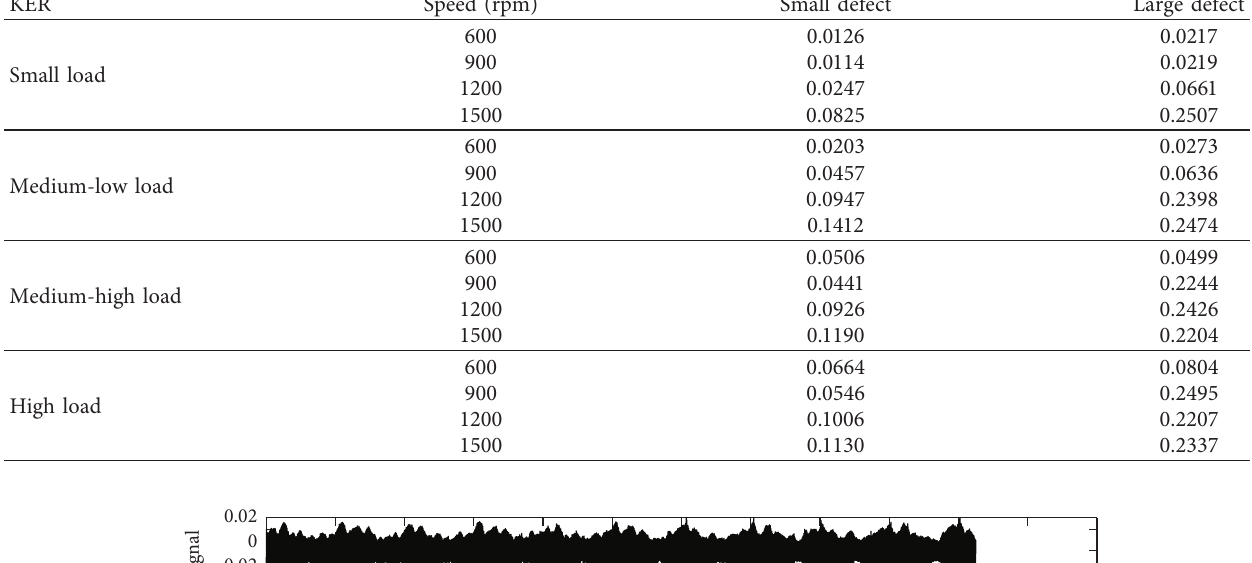
Table 3: Value of KER for outer race defect at different conditions.